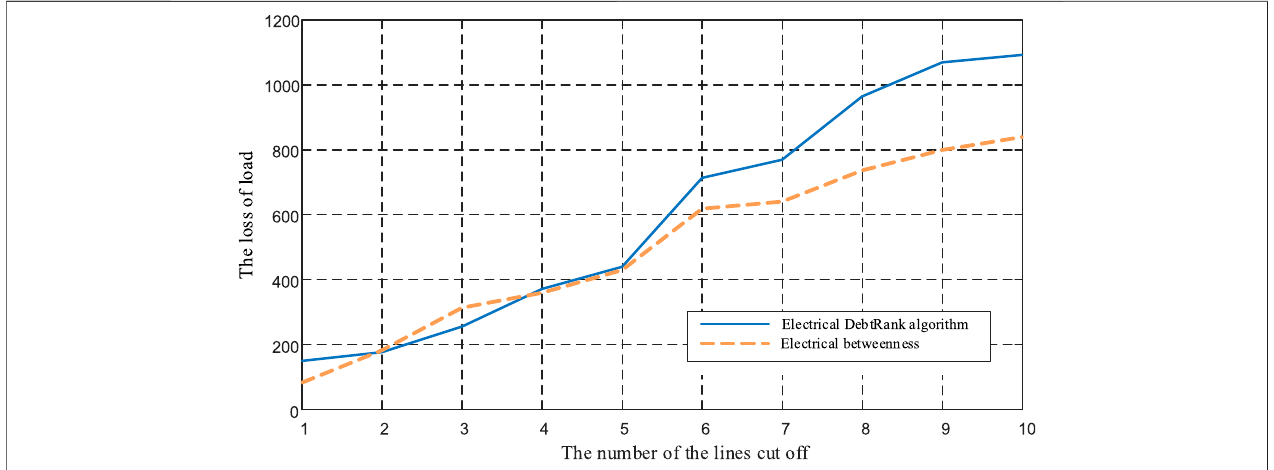
FIGURE 7 | IEEE-118 power system removes the fi rst 10 vulnerable lines; load loss comparison diagram.